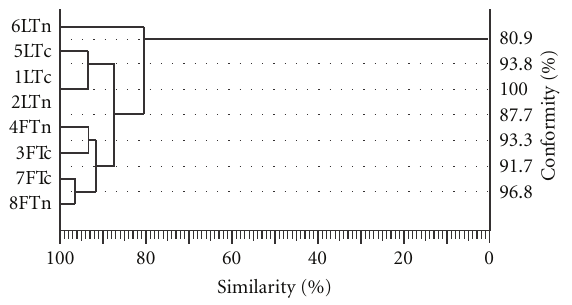
Figure 5: Dendrogram of fatty acid profiles similarity created by a numerical cluster analysis (F: deep-frozen; L: lyophilized; Tn: thin; Tc: